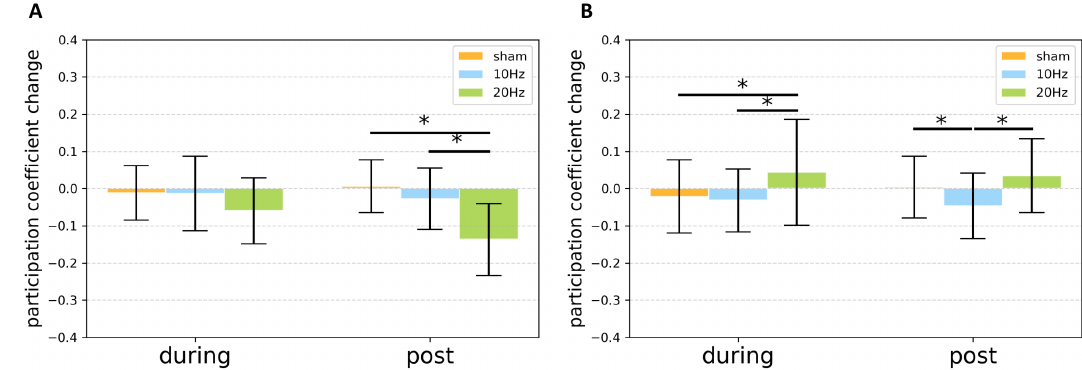
Figure 5. The bar chart of participation coefficient change of brain networks ( A ) in motor-related regions as well as ( B ) at the whole-brain level for various conditions during and after stimulation. Error bar stands for the standard error. Asterisk (*) indicates that a significant difference was observed at p <